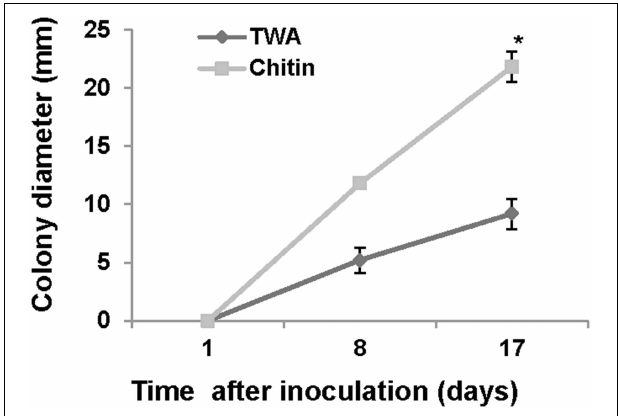
FIGURE 6 | Chitinase activity. Growth of P. aphidis on 0.1% chitin as compared to TWA. Averages of five samples are presented with standard-error bars. Asterisks indicate a significant difference as determined by Student’s t -test; P < 0 . 05 .